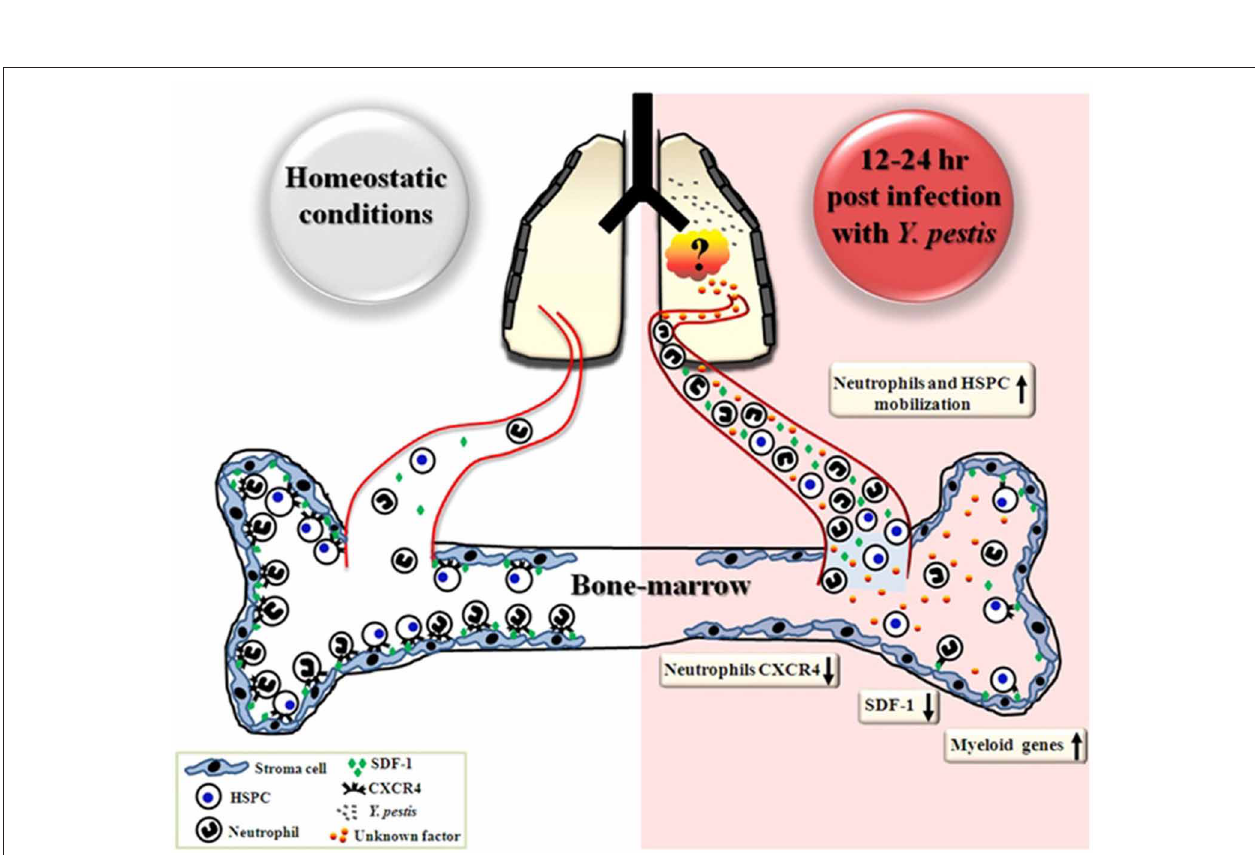
FIGURE 5 | RT-PCR analysis of myeloid vs. lymphoid associated genes expressed by total BM cells. Expression levels of representative genes involved in myeloid (left) and lymphoid (right)